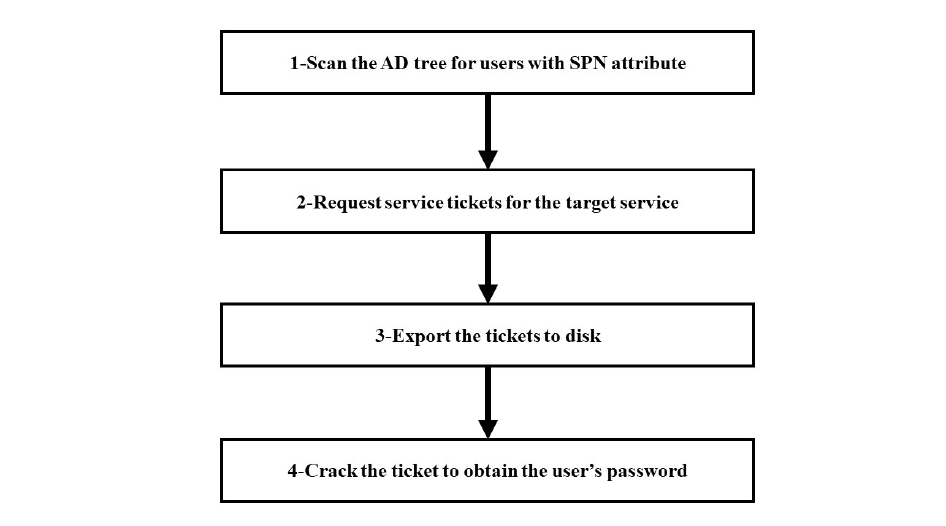
Figure 3. Kerberoasting attack